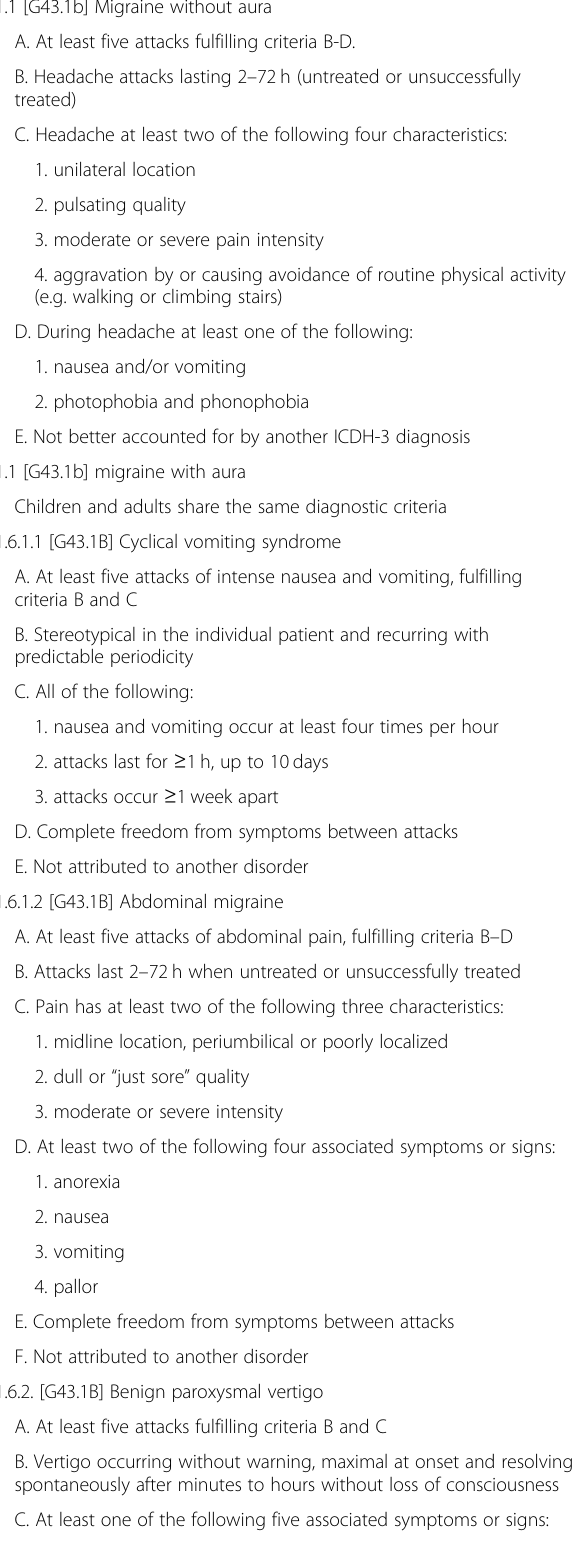
Table 21 Classification of headache in children [2]